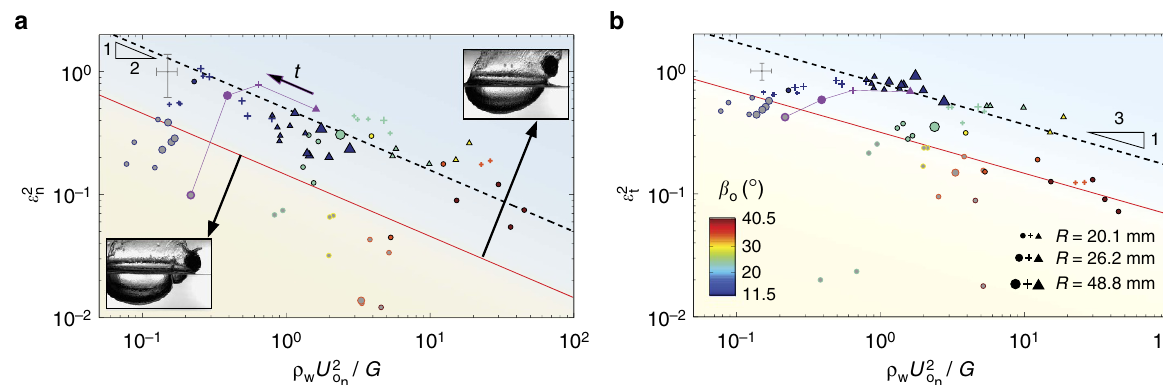
Figure 7 | Restitution coefficients of elastic spheres skipping on water. Experiments reveal the dependence of the square of the normal ( a ) and G (grey-filled symbols denote mode 1 (cid:2) transitional skips; marker shapes same as for Fig. 6; r * ¼ 1 ± 0.08). tangential ( b ) restitution coefficients on r w U 2 o n = We find that e 2 and e 2 scale with r w U 2 = G in the same way that for bouncing liquid drops 28 they scale with We o n t o n skipping elastic solid spheres plays the role of the Laplace pressure s / R d for bouncing liquid droplets. Because rebound is more efficient in the tangential direction, b o decreases (thus becoming more favourable) with each skip. In addition, both restitution coefficients increase with decreasing impact speed until the sphere enters the mode 1 (cid:2) skipping and transitional regimes. These two effects combine to enable multiple skip trajectories (Figs 6 and 8, Supplementary Movie 3). The demise of a multiple skip event starts when t c / t w 4 1 and a matryoshka cavity forms (below red lines); e 2 rapidly when this occurs. This interpretation is confirmed by a multiple skip experiment; the purple markers on each plot correspond to the multiple skip experimental data shown in Figs 6 and